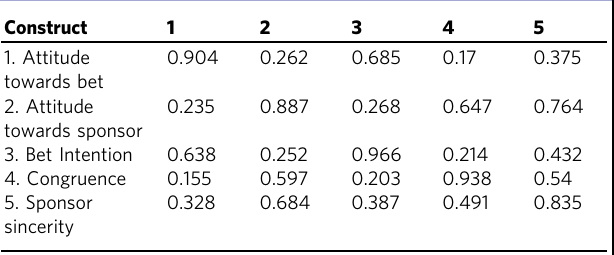
The diagonal values show the square root of the AVE. The lower diagonal values are interconstruct correlation, and the upper- diagonal values are the heterotrait-monotrait ratio of correlation.